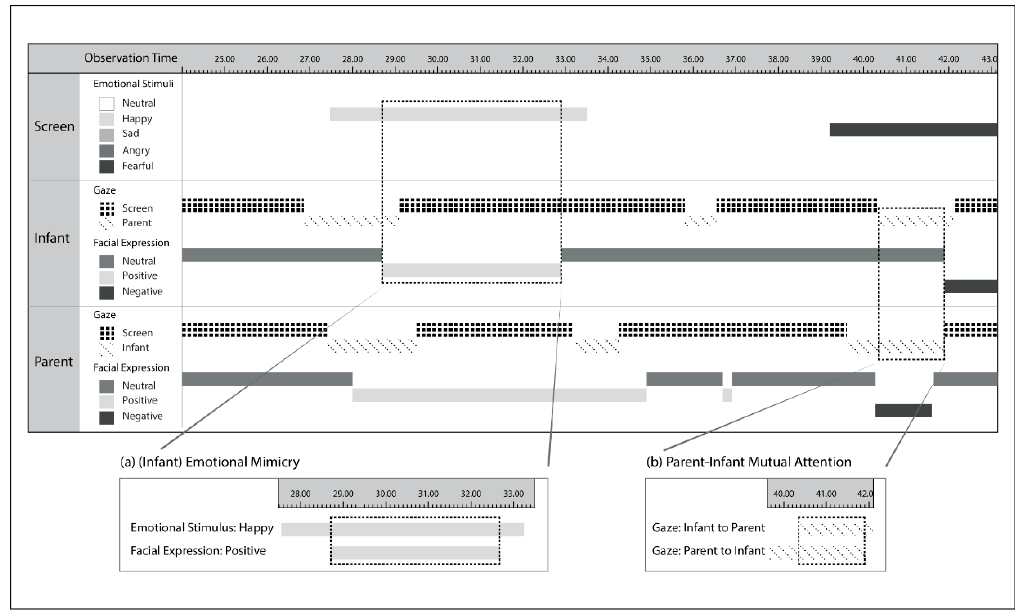
Figure 3. Data visualization examples. ( a ) Emotional mimicry, operationalized as temporal co-occurrence) of the infant’s negative facial expression to the sad emotional stimulus. ( b ) Parent-infant mutual visual attention, operationalized as temporal co-occurrence of parent’s and infant’s gaze toward each other.